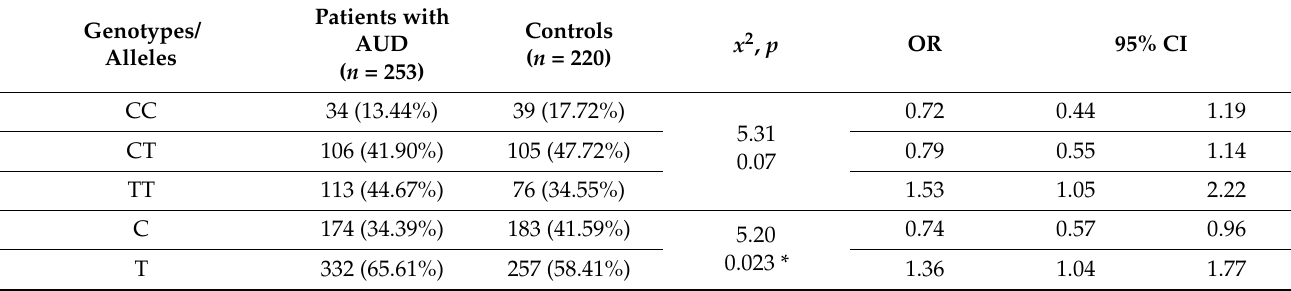
Table 1. The comparison of PIP4K2A rs746203 genotypes and alleles distribution in men with AUD and healthy men. Genotypes/ Alleles